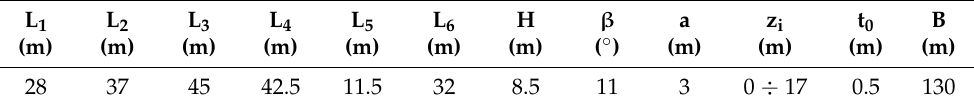
Table 1. Dimensions of the scheme for formulation of the